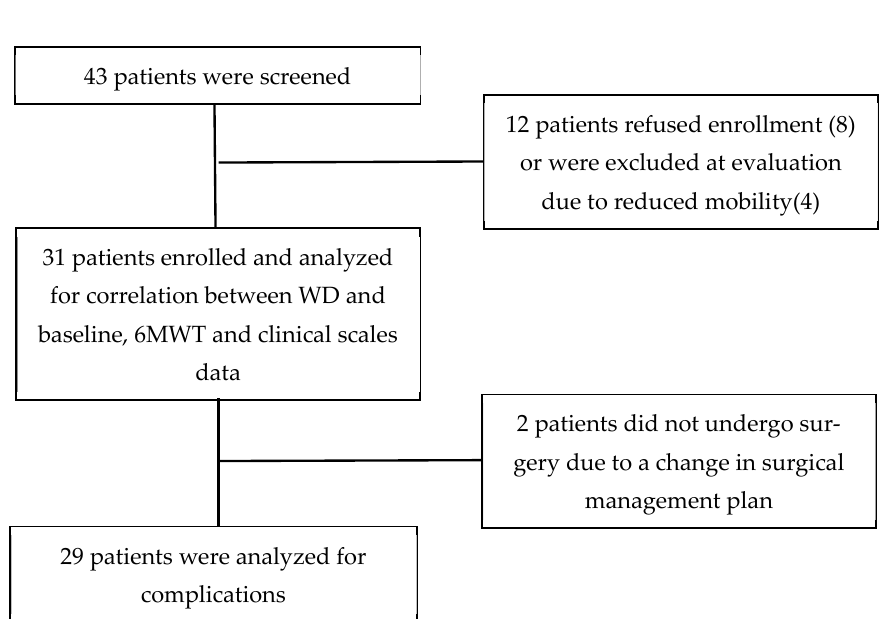
Table 1. Preoperative data, according to ASA class. BMI = Body Mass Weight, CFS = Clinical Frailty Scale, MET = Metabolic equivalent of tasks, DASI = Duke Activity Status Index.